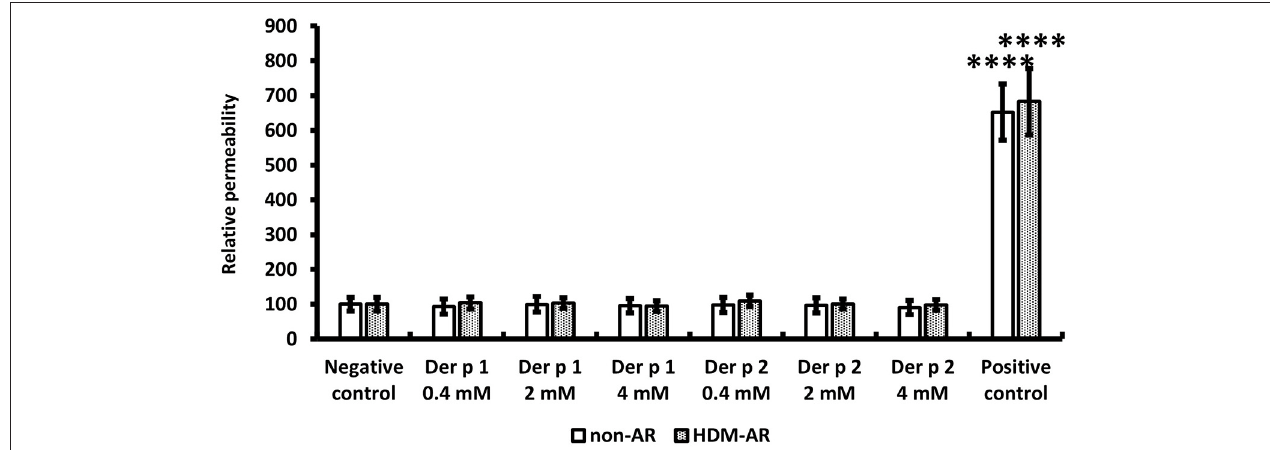
FIGURE 2 | Paracellular permeability was not affected by HDM extracts. FITC-dextran passage was measured in each treated sample after 6h TEER measurement and normalized to the negative control. PBS was used as the negative control and 5% Triton was used as the positive control. The data is shown as the means ± SEM. ( n = 9; respectively for each group). **** p < 0.0001, one-way ANOVA followed by Dunnett’s